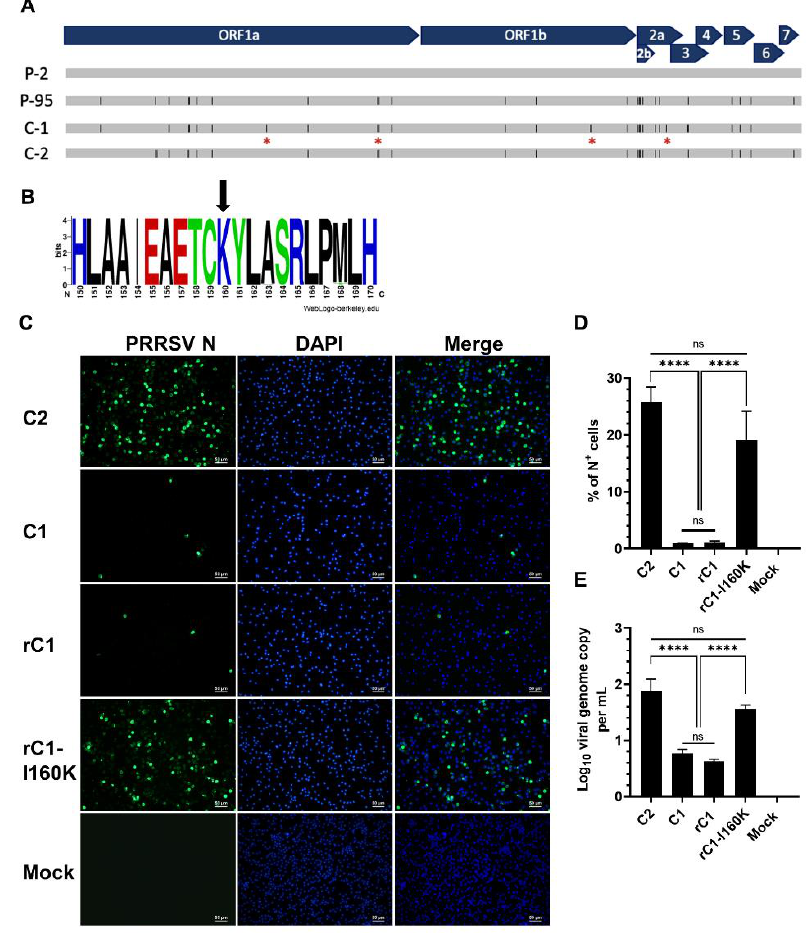
Figure 4. A single amino acid substitution in GP2 of C1 is responsible for impaired infectivity in PAMs. ( A ) Schematic representation of NCV1 P2, P95, C1, and C2 genomes and mutations. The virus genome organization and open reading frames are shown on top. Gray horizontal lines represent the full-length genome of indicated viruses. Black vertical bars within the gray lines depict amino acid substitutions as compared to P2. Red asterisks depict amino acid substitutions that were only found in C1. ( B ) Web logo showing the conservation of PRRSV-2 GP2 amino acid residue 150 to 170 constructed from 1467 available GenBank sequences. Web logo was constructed using the WebLogo online software (WebLogo-berkeley.edu). ( C – E ) Analysis of virus infectivity in PAMs at high MOI. The experiment was conducted in the same manner as described in Figure 2. ( C ) Representative images of cells that were fixed and stained with an anti-N antibody to visualize virus-infected cells (green color). DAPI was used to stain the nuclei (blue color) . Scale bar = 50 μm. ( D ) Percentage of PAMs expressing N protein as quantified by flowcytometry. ( E ) Difference of viral genome copy numbers in the culture supernatants collected at 0 hpi and 12 hpi as quantified by RT-qPCR. Data are presented as means and SEM of the three independent experiments, each of which involved four populations of PAMs collected from four different pigs. ns: non-statistically significant, **** p < 0.0001. Table 4. Mutations only found in the C1 virus but not in the P95 and C2 viruses.